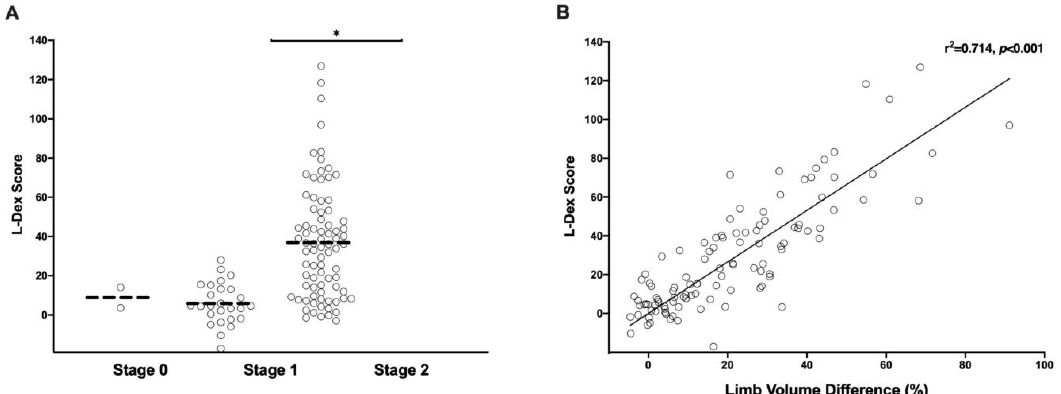
Figure 3. ( A ) Scatter plot of upper extremity L-Dex score distribution by ISL stages; ( B ) Correlation plot of limb volume difference (%) vs. L-Dex score.